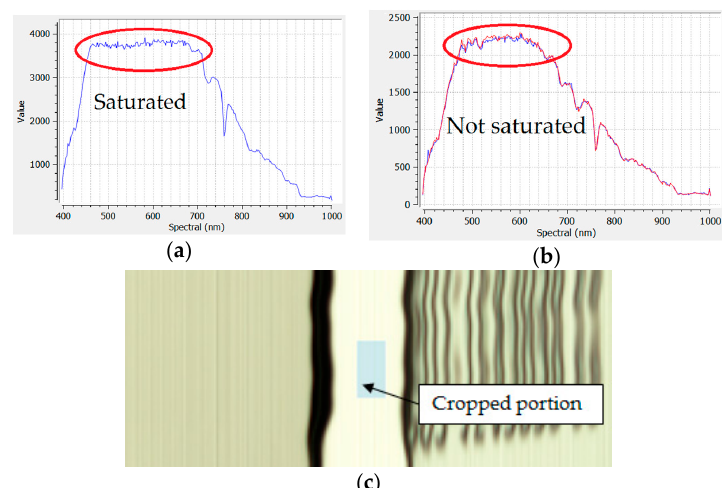
Figure 3. Hyperspectral white reference processing. ( a ) Saturated values around the highlighted area; ( b ) Maximum values are not saturated and this white target portion can be used for obtaining reflectance; ( c ) Cropped portion of the white reference board image with higher radiance values.